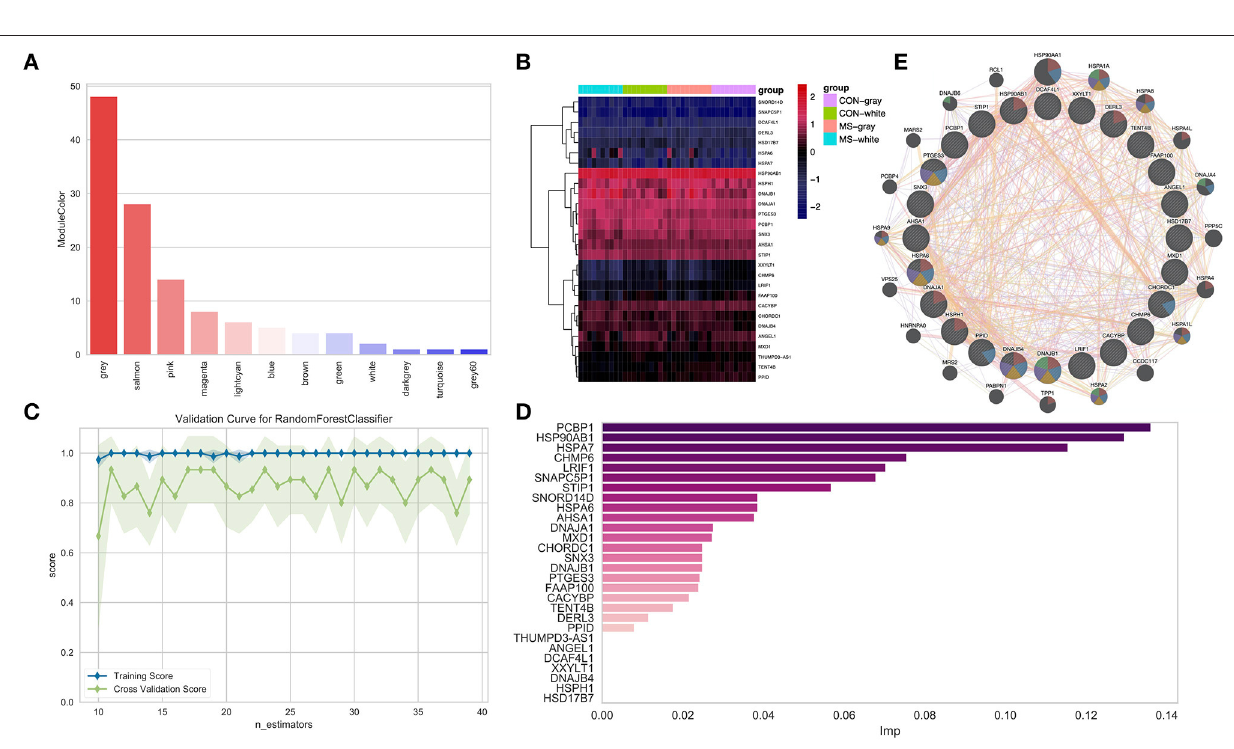
FIGURE 5 | (A) Identifying the overlap genes between DEGs and genes in consensus modules. (B) Heatmap shows the expression of the overlapping genes in the midnightblue module. (C) The plot shows the changes of the f1 index with the changes of the max-feature in the training set and test set. (D) The bar plot shows the relative importance of features (genes) in the random forest classification model. (E) The PPI network of important genes via